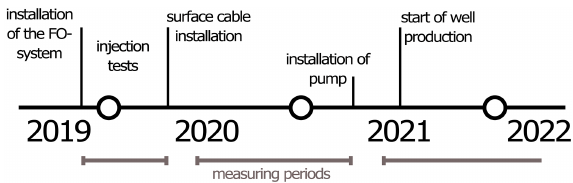
Figure 2. Timeline of fiber optic DTS measurements at SLS